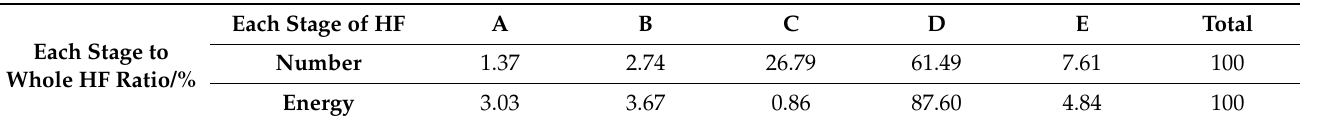
Table 3. The ratio of waveforms’ numbers and energy of the dominant frequency bands in each stage to that in the whole HF